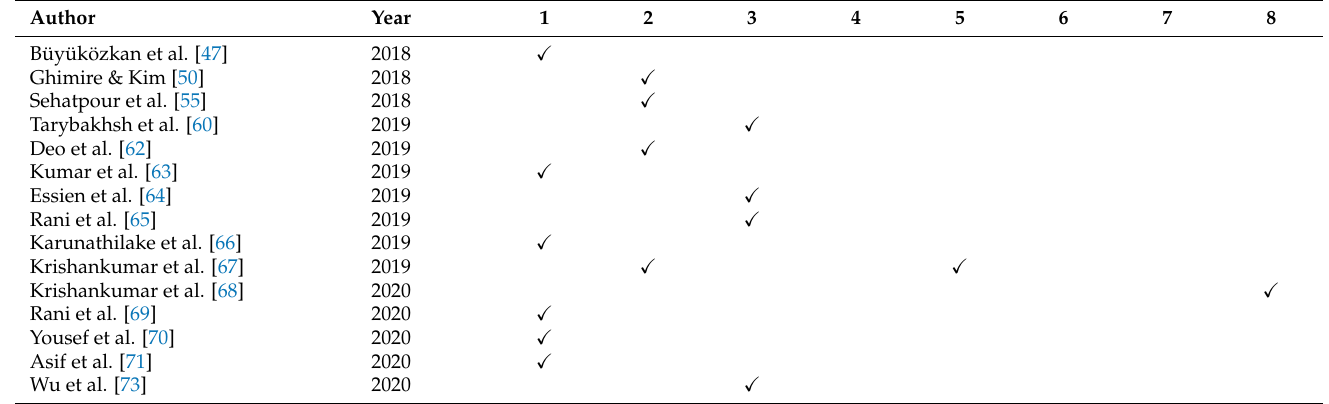
Table 3. Distribution of fuzzy sets and variants used in decision models for CES study